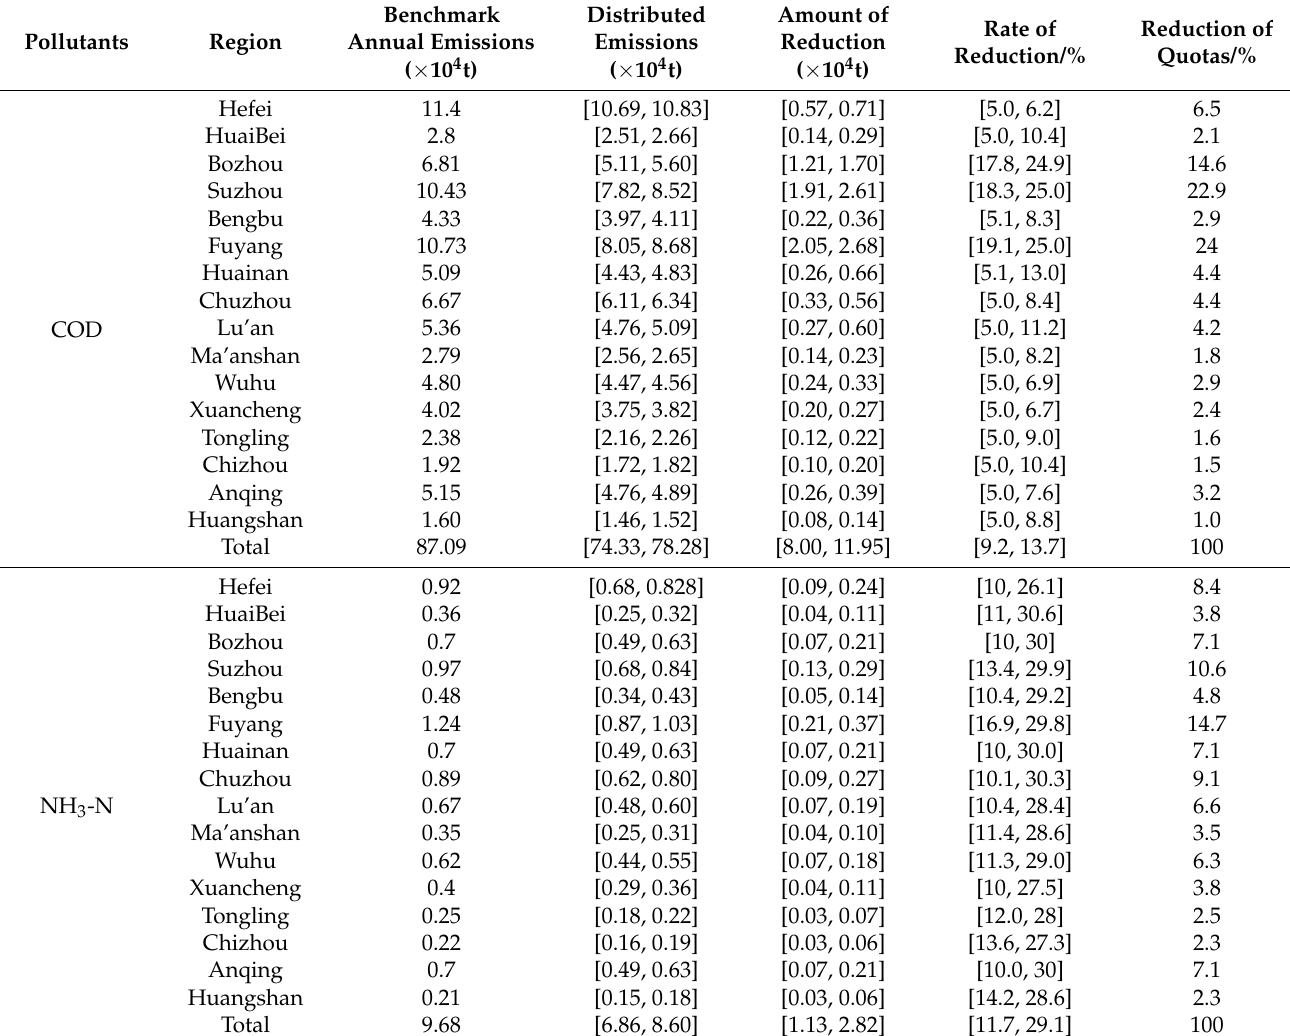
Table 4. Water pollution load distribution and reduction plan of Anhui Province in